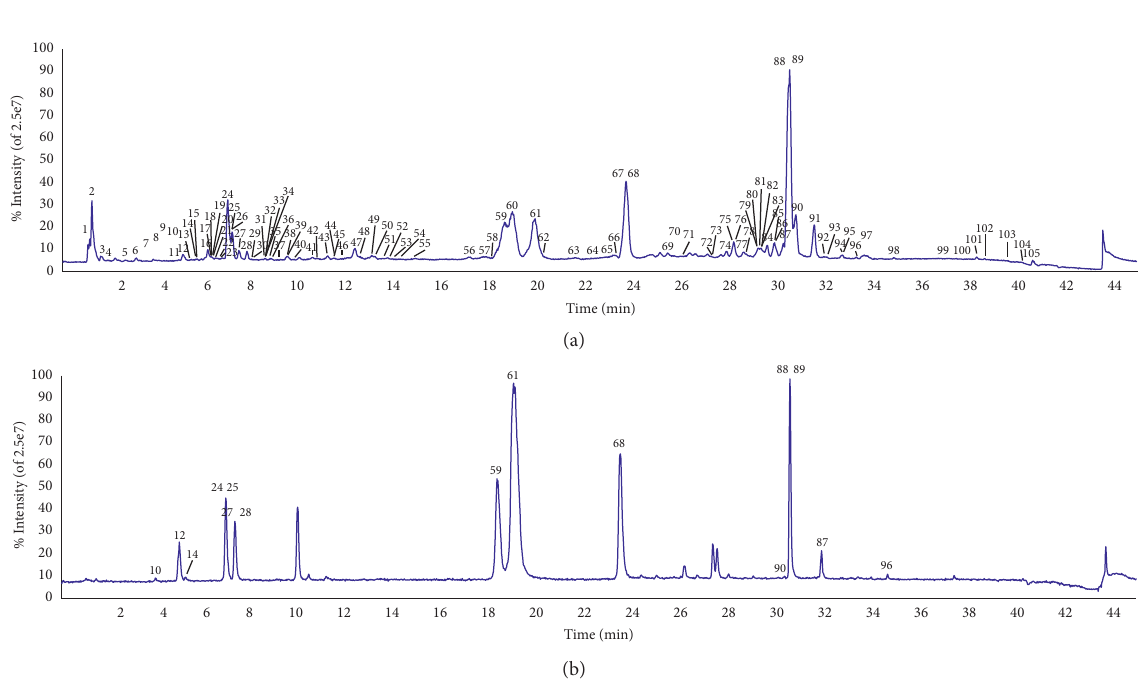
Figure 2: TIC of (a) Ilicis Rotundae Cortex (IRC) and (b) the 15 mixed standard compounds in the negative ion